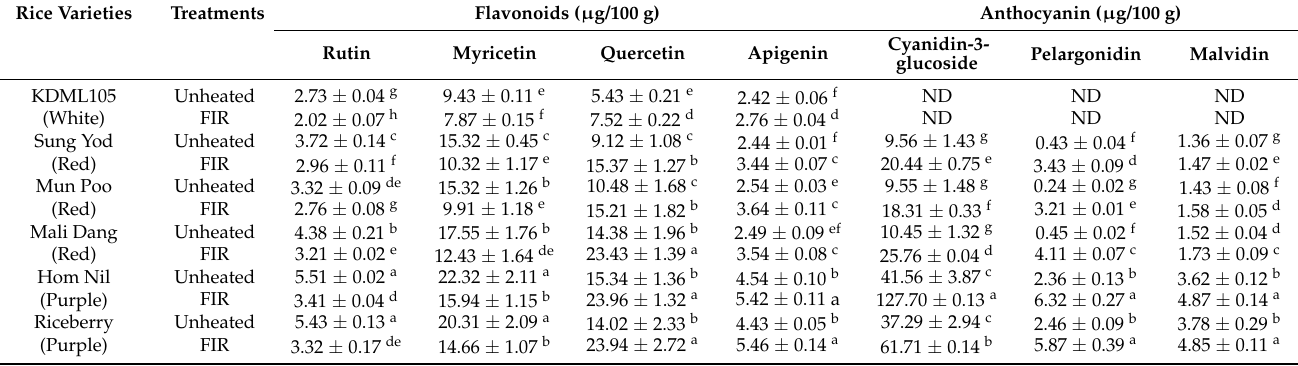
Table 2. Identifications of flavonoids and anthocyanin in pigmented rice varieties as affected by FIR. Rice Varieties